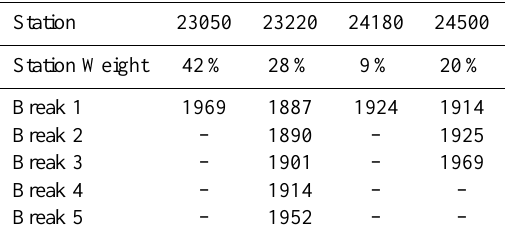
Table 1. Results from SNHT-analysis of precipitation stations.